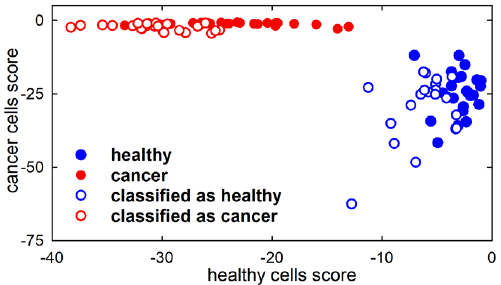
Figure 3. Discrimination plot from linear discriminant analysis model, developed using three principal components. The scatter plot shows the discrimination of healthy FHC cell spectra (filled blue circles) and cancerous CaCo-2 cell spectra (filled red circles). The projections of the test samples on the PCA-LDA model are shown as hollow circles.